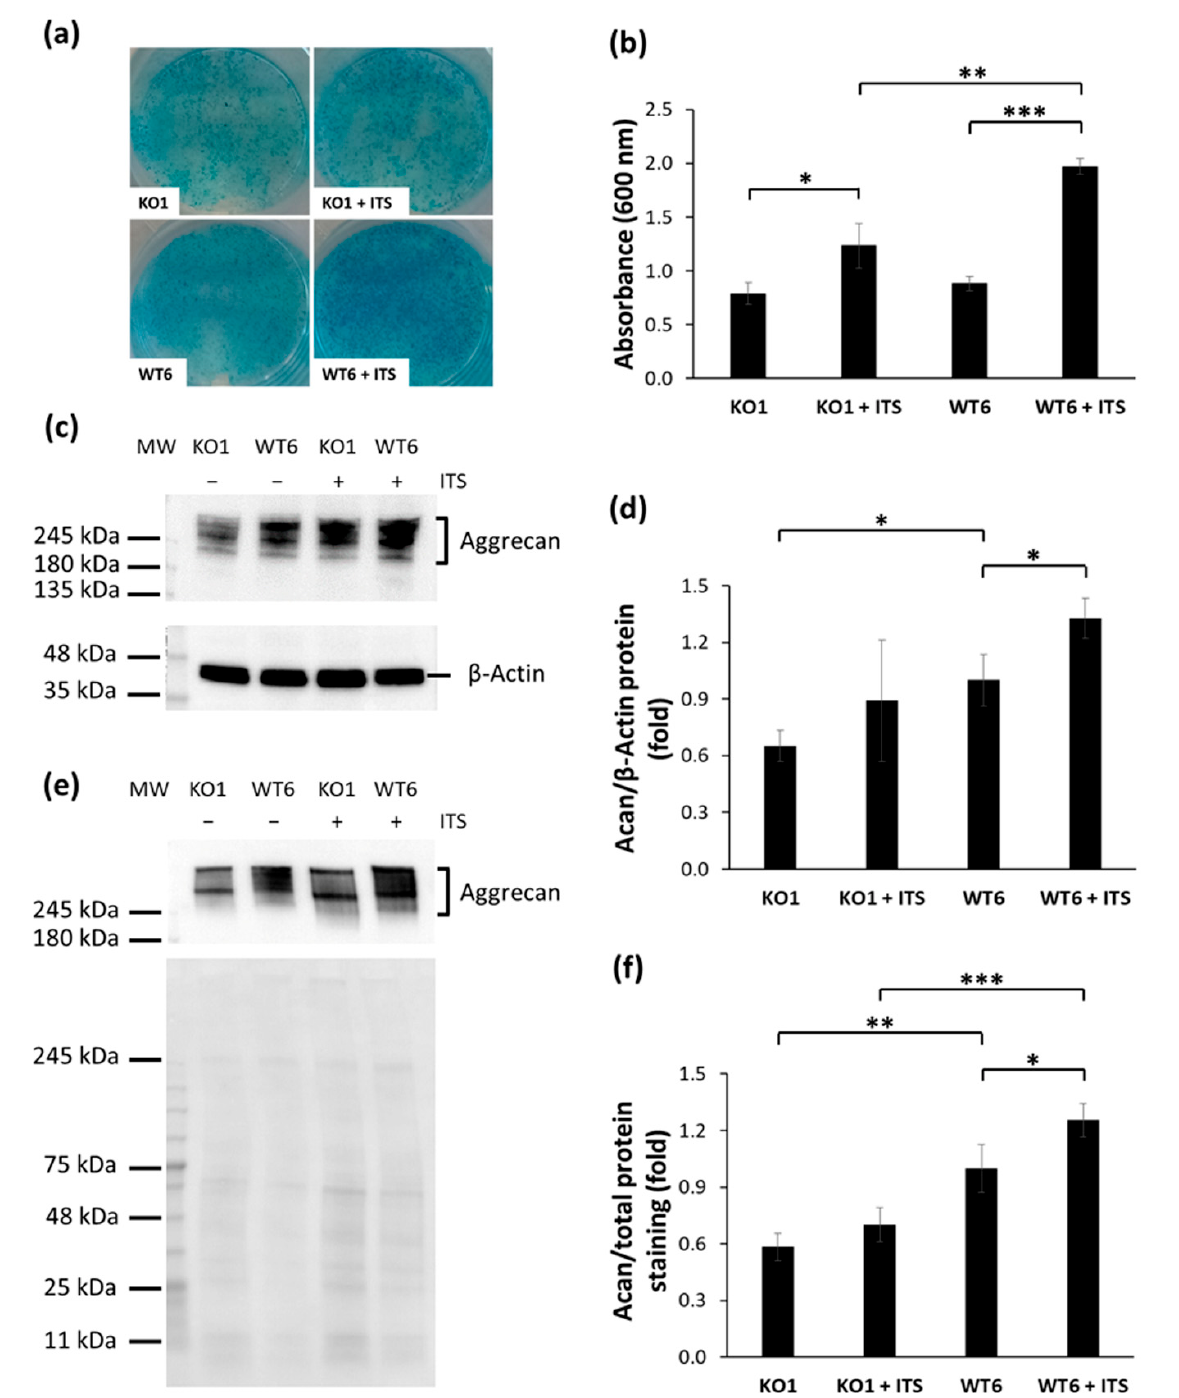
Figure 5. Synthesis and deposition of extracellular matrix proteins in immortalized chondrocytes. ( a ) Alcian blue staining of immortalized chondrocytes incubated with or without ITS for 12 days. ( b ) Spectrophotometric measurement after Alcian blue extraction. Data are reported as mean ± standard deviation of three replicates. Significance among samples was analyzed by Student’s t -test; * p < 0.05; ** p < 0.01; *** p < 0.001. Alcian blue staining demonstrated that after 12 days of ITS incubation PG deposition was increased in both immortalized Cant1 knock-out and wild-type chondrocytes and WT6 cells synthesized more PGs compared with KO1. ( c ) Western blot of proteins extracted from the cell layer of immortalized chondrocytes incubated with or without ITS for 12 days was performed with specific antibodies against aggrecan core protein and against β -Actin as internal control. MW = molecular weight. ( d ) Densitometric quantification of blots from cell